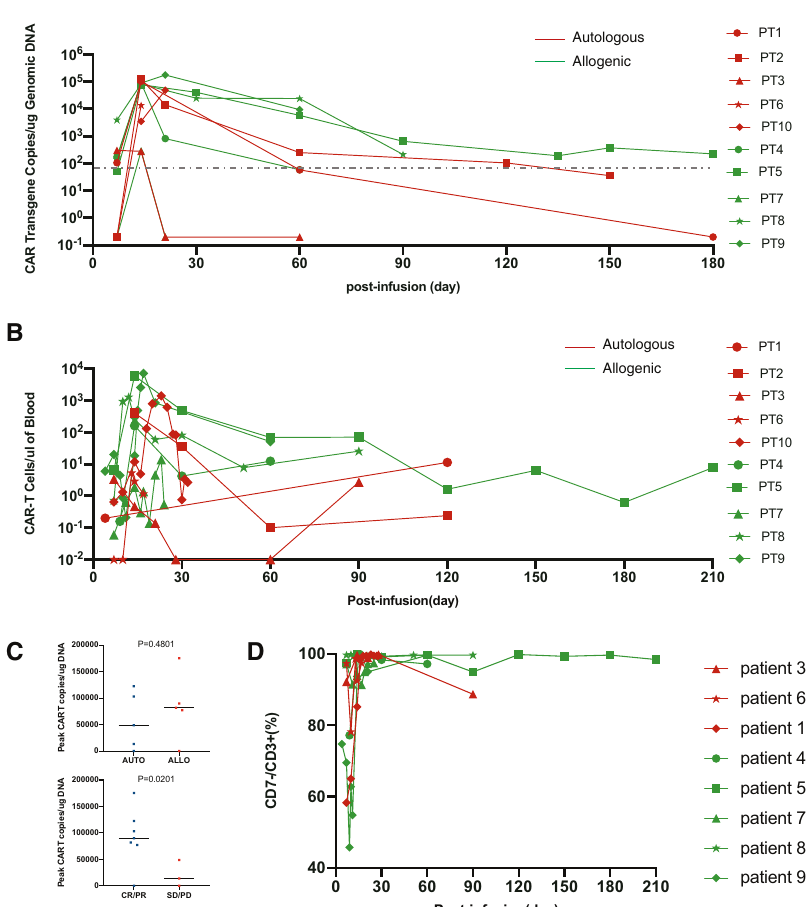
Fig. 3 CAR-T cell expansion and persistence. A Kinetics of CAR vector transgene copies per microgram of genomic DNA of peripheral blood mononuclear cells in individual patients measured by ddPCR. The dotted line indicated the threshold determined by quantitation of normal samples. B Kinetics of CD7- CAR-T cells in peripheral blood detected by FCM. C Correlation of the peak CAR copies in the peripheral blood with sources and ef fi cacy. D The percentages of CD7 + T cells were determined by FCM. Due to the lack of specimens, the condition of patients 1 and 2 could not be